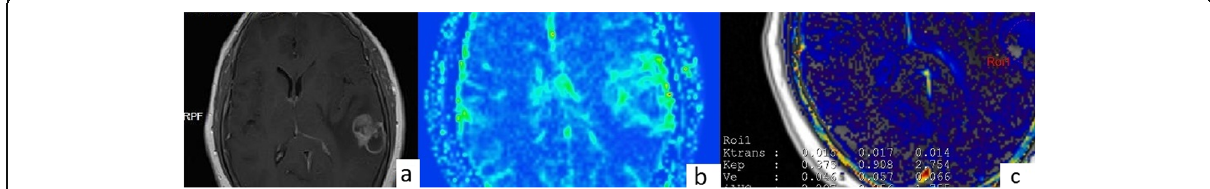
Fig. 2 A 60-year-old female. Heterogeneously enhancing mass in the left parietal lobe on T1WI axial image. Perilesional oedema is also present ( a ). There is an increased perfusion on rCBV map ( b ). Permeability data indicates low-grade glioma (Ktrans 0.017, Ve 0.057) ( c ). Pathological diagnosis is WHO grade 3 glioma (anaplastic astrocytoma)